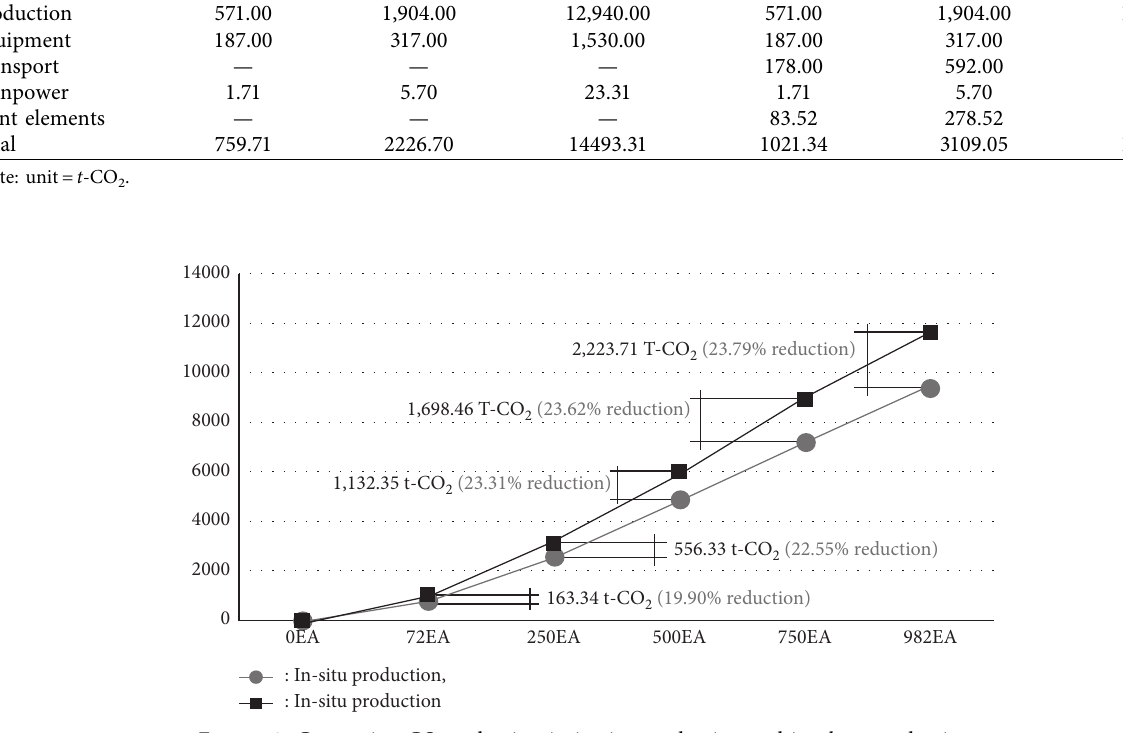
Figure 3: Comparing CO 2 reduction in in situ production and in-plant production.